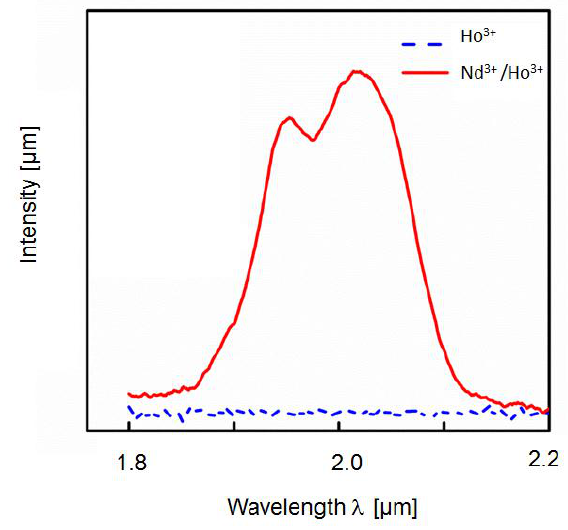
Figure 1. Emission spectra of Ho 3+ and Nd 3+ /Ho 3+ co-doped tungsten tellurite glasses. Figure adapted from [18].